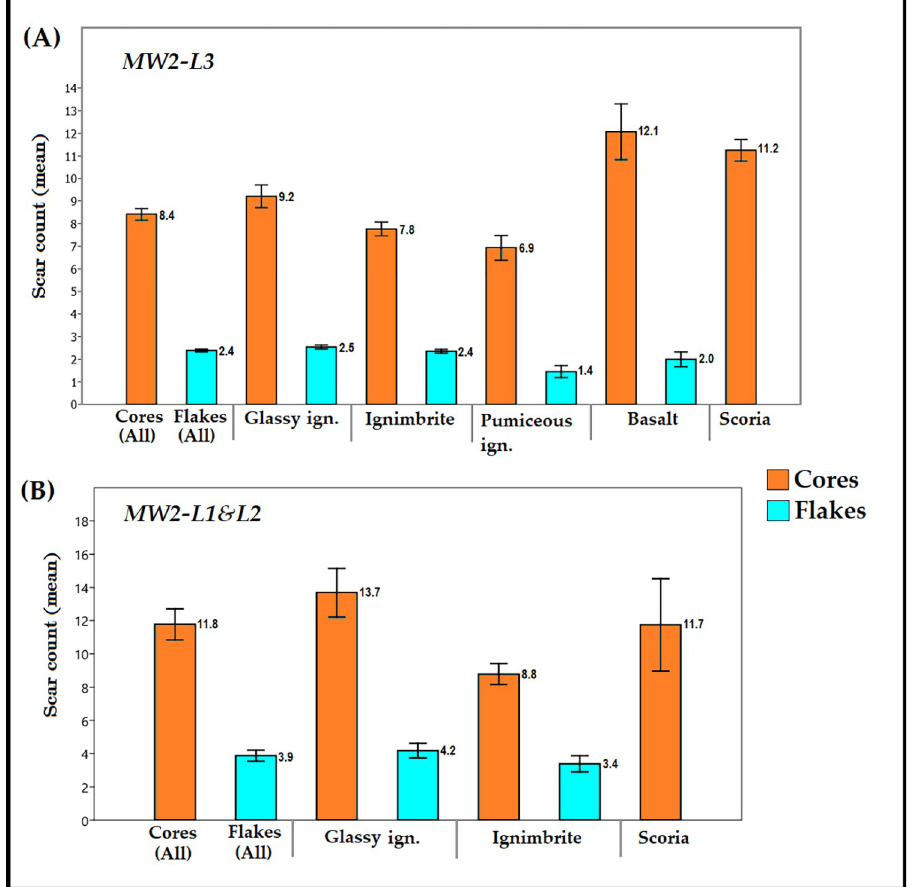
Fig 5. Box plot (with standard error) showing the average scar counts on the surface of cores and flakes (as per raw materials represented) from A) MW2-L3 and B) MW2-L1&L2.